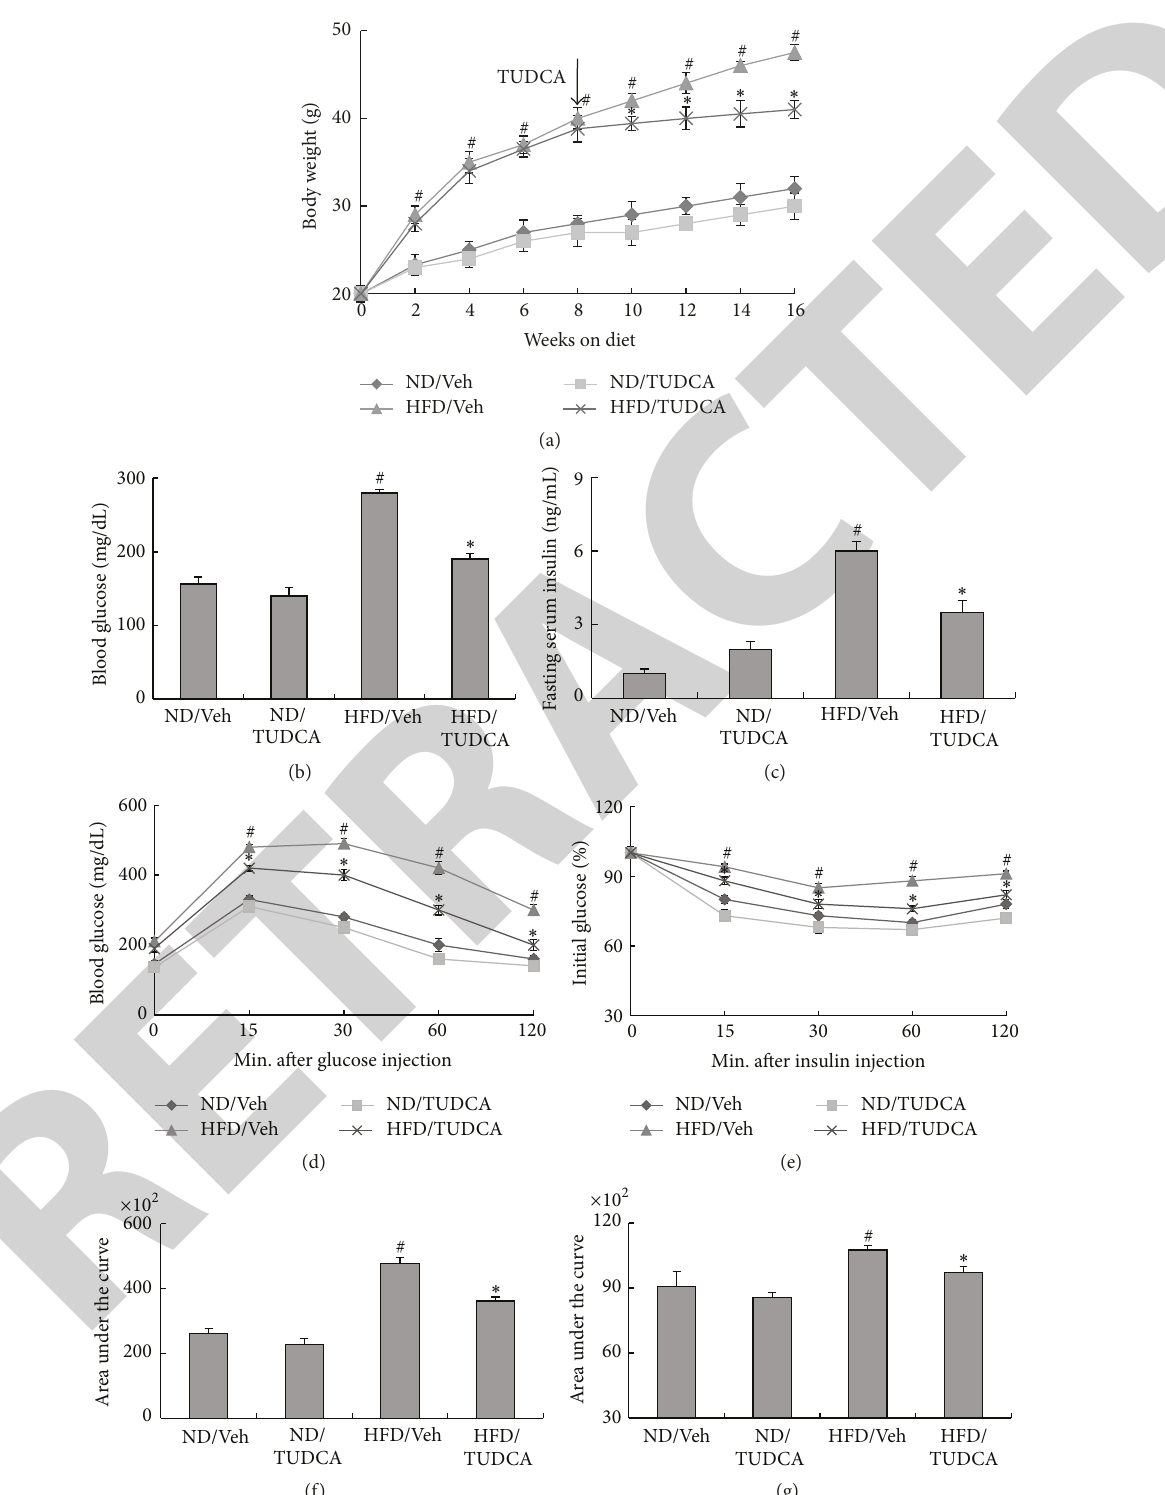
Figure 1: Effects of TUDCA on systemic glucose homeostasis and insulin sensitivity in obese mice. All analyses were performed in mice fed a normal diet (ND) or a high-fat diet (HFD) for 8 weeks and then injected daily with 500 mg/kg of TUDCA or with vehicle (Veh) for 8 weeks. (a) Body weight. (b) Blood glucose. (c) Serum insulin. (d) Glucose tolerance testing (GTT). (e) Insulin tolerance testing (ITT). (f) Area under the curve by GTT. (g) Area under the curve by ITT. Fifteen mice per group were analyzed. The data was expressed as mean ± SEM in each bar graph. ∗ 𝑃 < 0.05 (HFD/TUDCA versus HFD/Veh). # 𝑃 < 0.05 (HFD/Veh versus